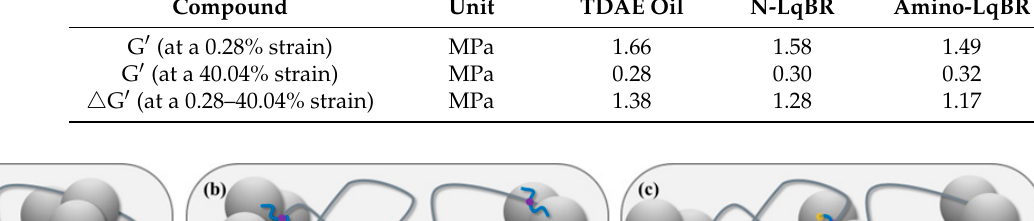
7:11 The results of the cure characteristics obtained using the MDR are presented in Figure 6 and Table 6. The MDR curve shows that the Δ torque (T max – T min ) value was closely related to the crosslink density of a compound [41]. The measurement results show that the Δ torque value of the N-LqBR compound was lower than that of the TDAE oil compound. This result shows that low crosslink density was achieved, which may have been due to N-LqBR partially consuming the sulfur that was needed to crosslink the base rubber [9]. Similar to N-LqBR, amino-LqBR may also consume sulfur. However, its functional groups are not only bonded to the carbon black surface, but also form chemical bonds with the base rubber via a crosslink reaction and may enhance the filler–rubber interaction. As a result, the amino-LqBR compound showed the highest Δ torque value among the compounds.